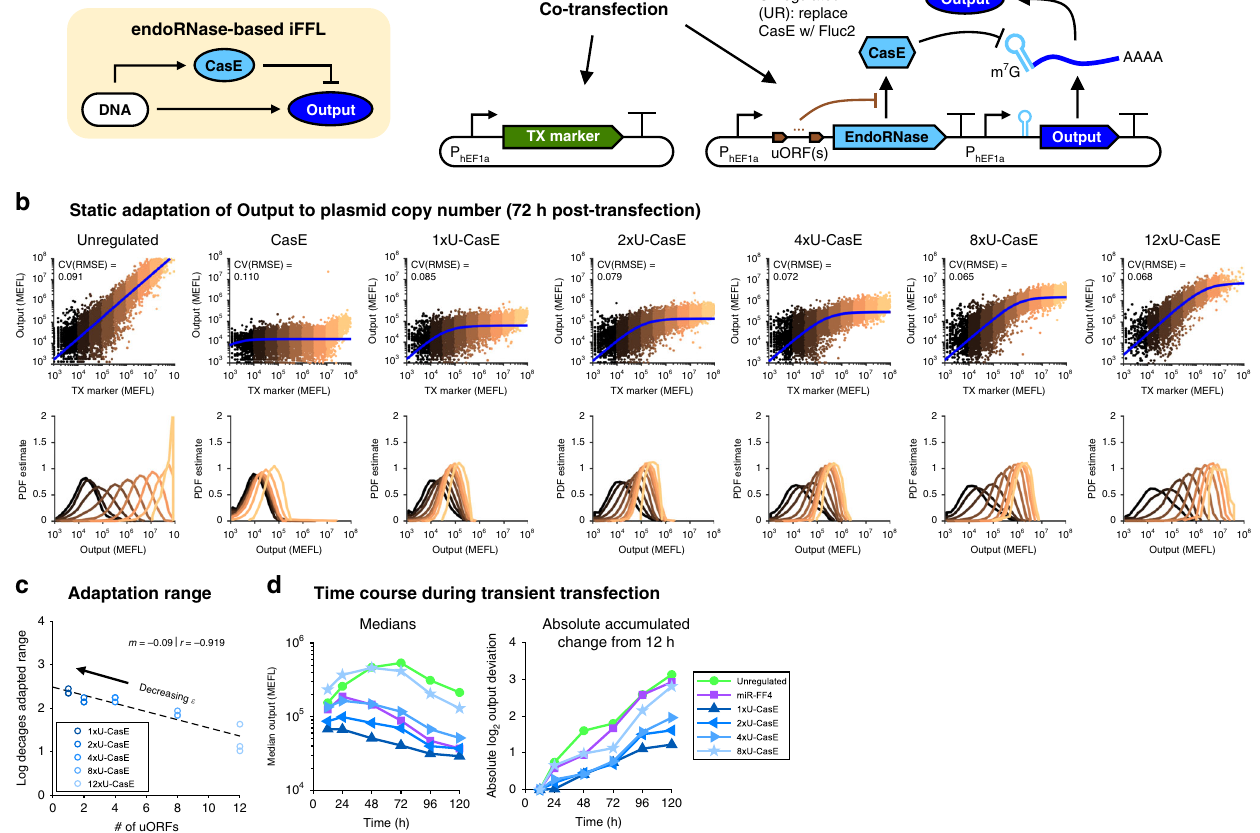
Fig. 6 Adaptation of the iFFL output level to DNA copy number variation. a Genetic diagram of the iFFL with hEF1a promoters, showing DNA as the input. No resource competitor was added in this experiment. The output is mNeonGreen. The constitutive TX marker (TagBFP) reports the plasmid dosage delivered to each cell. b Top row: TX marker vs output levels for each sample, overlaid with fi ts of the iFFL model. For the UR samples, the output is proportional to the TX marker, so we fi t with a simple linear formula: output = m ⋅ TX marker. The CV(RMSE) is the root-mean-square error between the model and non-binned data, normalized by the mean of the data (log 10 -transformed fi rst since the cell-to-cell variance is approximately log-normally distributed). To facilitate better comparability among plots, each bin was sub-sampled with the same number of cells ( n = 3000). Bottom row: histograms of the output levels for cells within each color-coded bin (as indicated in the scatters). Data are representative and taken from the fi rst of three experimental repeats. c Correlation between the range of DNA copy numbers over which the output of an iFFL variant is adapted and the number of uORFs in the 5 ′ UTR of CasE ’ s transcription unit. The adaptation range is de fi ned as the largest sum of the log widths of contiguous adapted bins in a sample (individual bins shown in Supplementary Fig. 36). Individual experimental repeats are shown separately. d Median expression over time for UR and iFFL variants (including a 5 ′ UTR-targeted miRNA-based iFFL for comparison — see Supplementary Fig. 38). The absolute accumulated change is the sum of the absolute values of the log 2 changes in median expression between time points, summed from 12 to 120 h. The results are from populations of cells gated positive for either output or TX marker. The iFFL variant with 0x-uORFs is omitted from panels ( c , d ) because its output level is nearly undetectable. Median values and fi t parameters are provided in Source